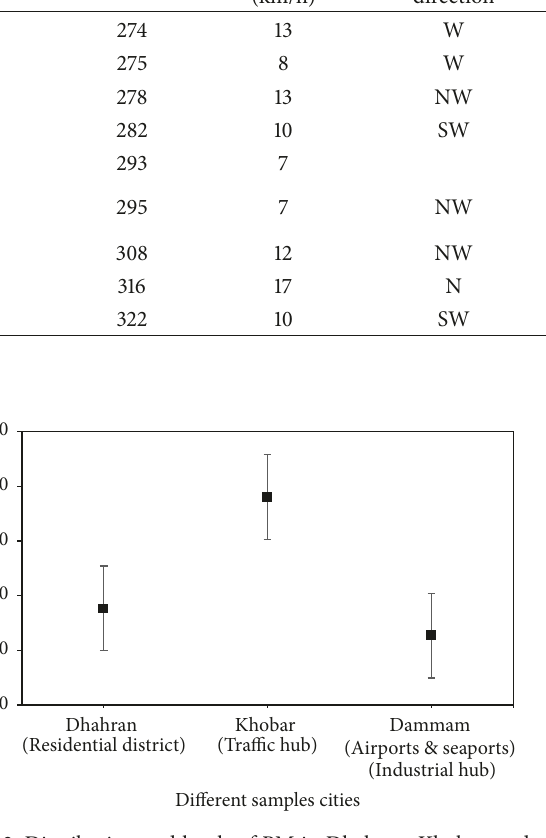
Figure 2: Distribution and levels of PM in Dhahran, Khobar, and